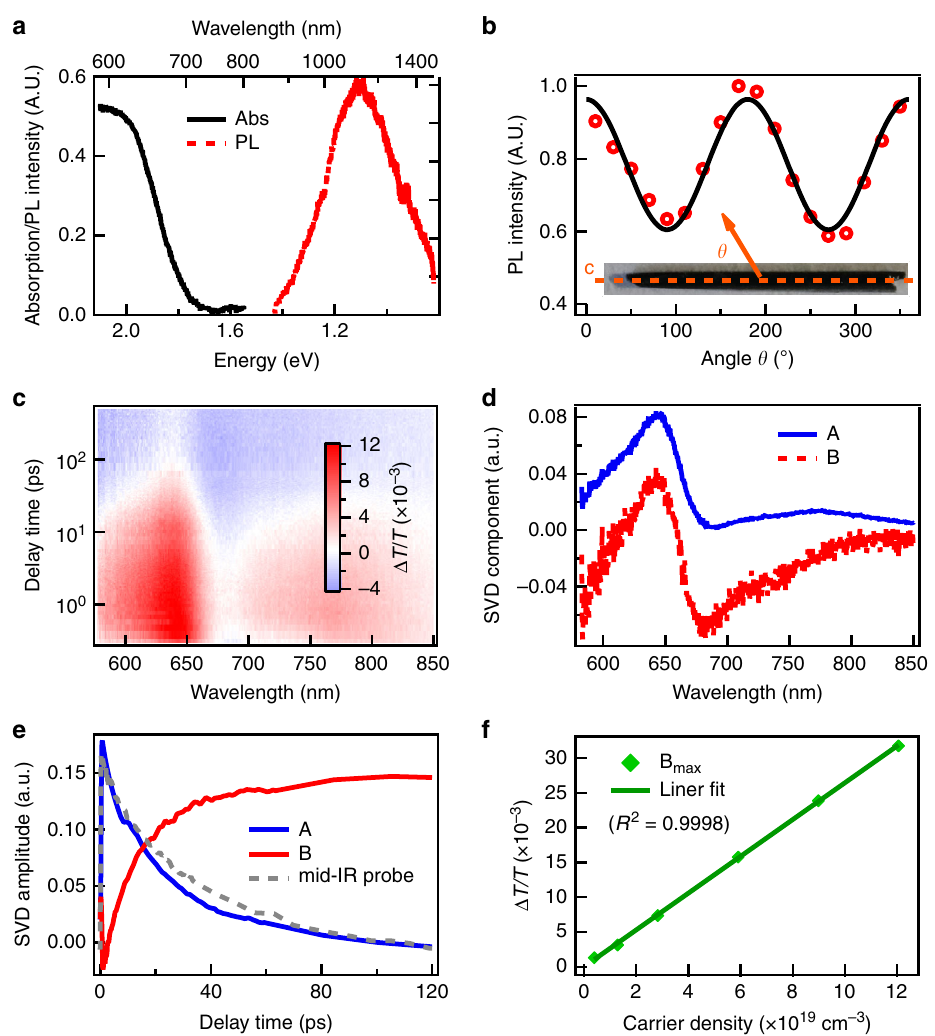
Fig. 3 Steady state and TA study of Sb 2 S 3 single crystal. a Absorption and PL spectra of Sb 2 S 3 single crystal. b PL intensity from a Sb 2 S 3 single crystal as a function of polarization detection angle ( θ ) and fi tting with cos 2 θ . θ is de fi ned to be 0 when detection polarization is along the crystal c- axis direction. Inset: optical image of a needle-like Sb 2 S 3 single crystal. c 2D color plot of TA spectra of Sb 2 S 3 single crystal. d Principle spectral components and ( e ) associated kinetics from SVD analysis. Also shown in Fig. 3e is the mid-IR (5 μ m) probe kinetics (gray-dashed line). f Maximum TA signal of B component as a function of photoexcited carrier density and its linear fi tting with R 2 equal to